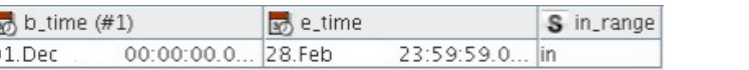
Figure 3. Data extraction range set on the input legacy node under time window filter meta node.